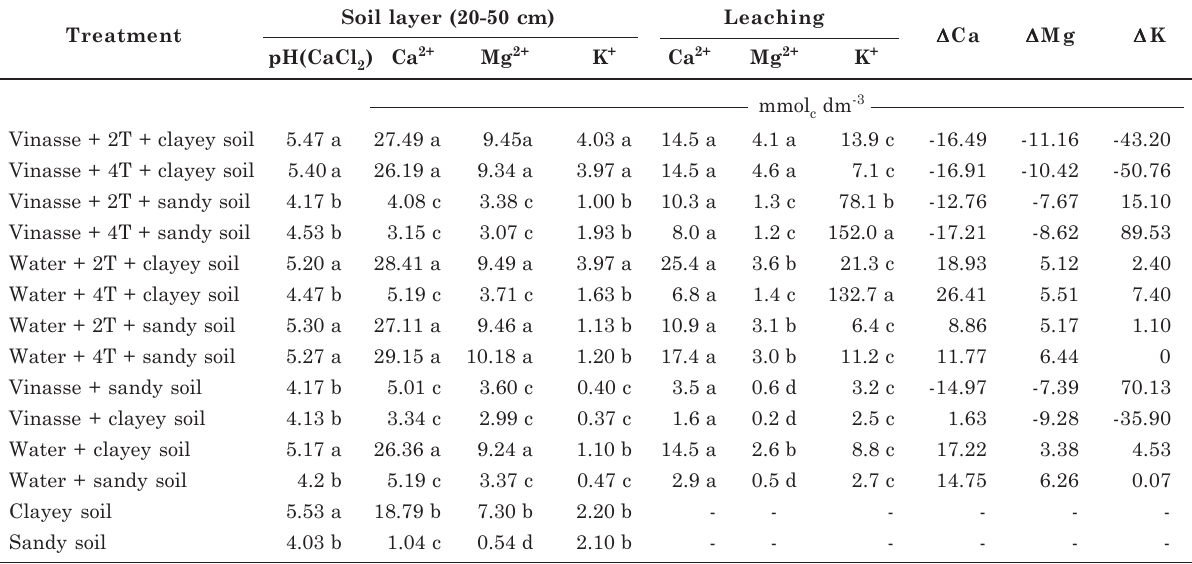
Table 3. Cation concentration in samples collected in the 20-50 cm soil layer and leaching, and the balance of calcium ( ∆∆∆∆∆ Ca), magnesium ( ∆∆∆∆∆ Mg), and potassium ( ∆∆∆∆∆ K) levels after 90 days of experimental